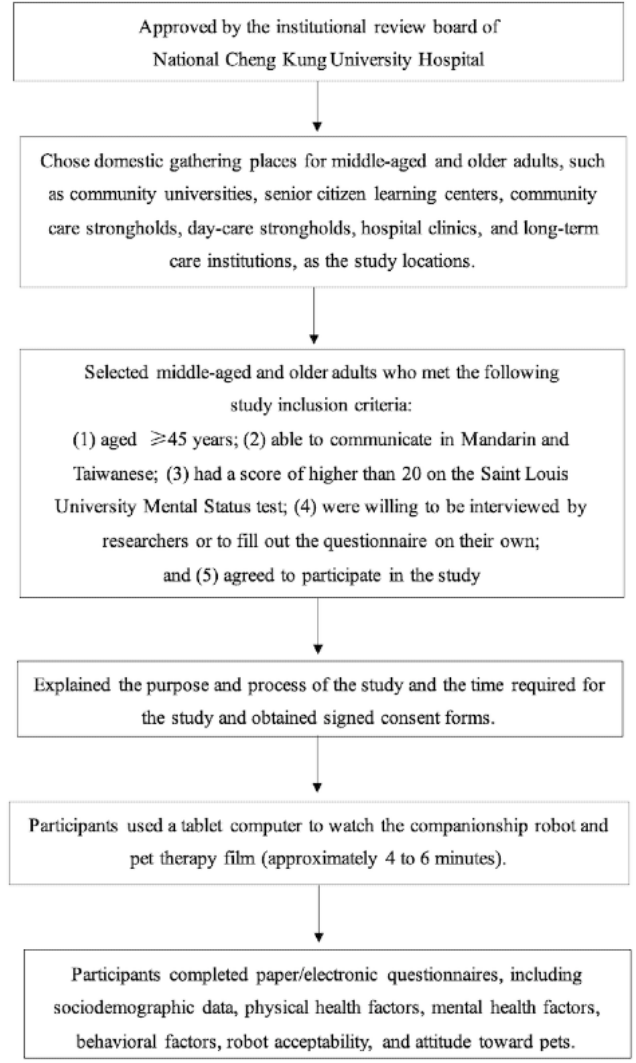
Figure 1. Research and data collection